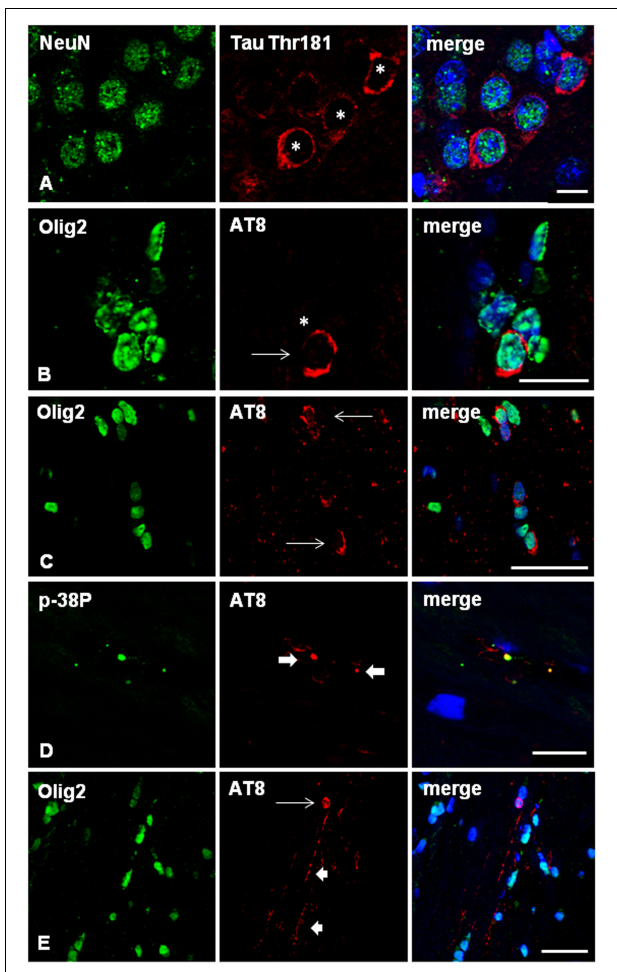
FIGURE 7 | (A–D) WT mice unilaterally inoculated in the hippocampus with sarkosyl-insoluble fractions from AGD at the age of 12 months and killed at 19 months (7 months survival) showing tau-immunofluorescent CA1 neurons (asterisks) in the ipsilateral hippocampus (A) , and deposits of hyper-phosphorylated tau in the cytoplasm of oligodendrocytes ( B,C ; arrows) as revealed with double-labeling immunofluorescence to NeuN (green) and P-tauThr181 (red), and Olig2 (green) and AT8 (red), respectively. Double-labeling immunofluorescence to phosphorylated p38 (p38-P, p38-PThr180-182) (green) and AT8 (red) in WT mice inoculated with sarkosyl-insoluble fractions from AGD at the age of 12 months and killed at the age of 19 months (7 months survival) (D) . Active p38 kinase (p38-P) co-localizes with tau deposits in tau-positive grains (thick arrows) and threads in the hippocampus. E: WT mouse unilaterally inoculated in the hippocampus with sarkosyl-insoluble fractions from PART at the age of 12 months and killed at 19 months (7 months survival) showing tau-immunofluorescent oligodendrocyte (thin arrow) and threads (short arrows) in the contralateral corpus callosum. Paraffin sections, nuclei stained with DRAQ5 TM (blue); (A) , bar = 10 µ m; (B) , bar = 30 µ m; (C,D) , bar = 10 µ m; (E) = 25 µ